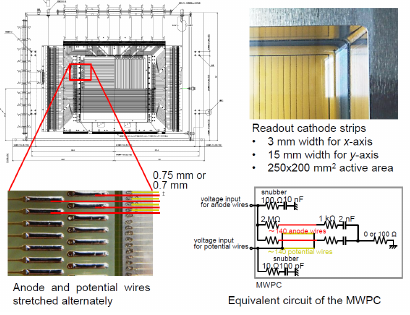
Figure 4: Structure of the MWPC. Figure 5: The circuit of high-voltage switching mod- ule and its simulation